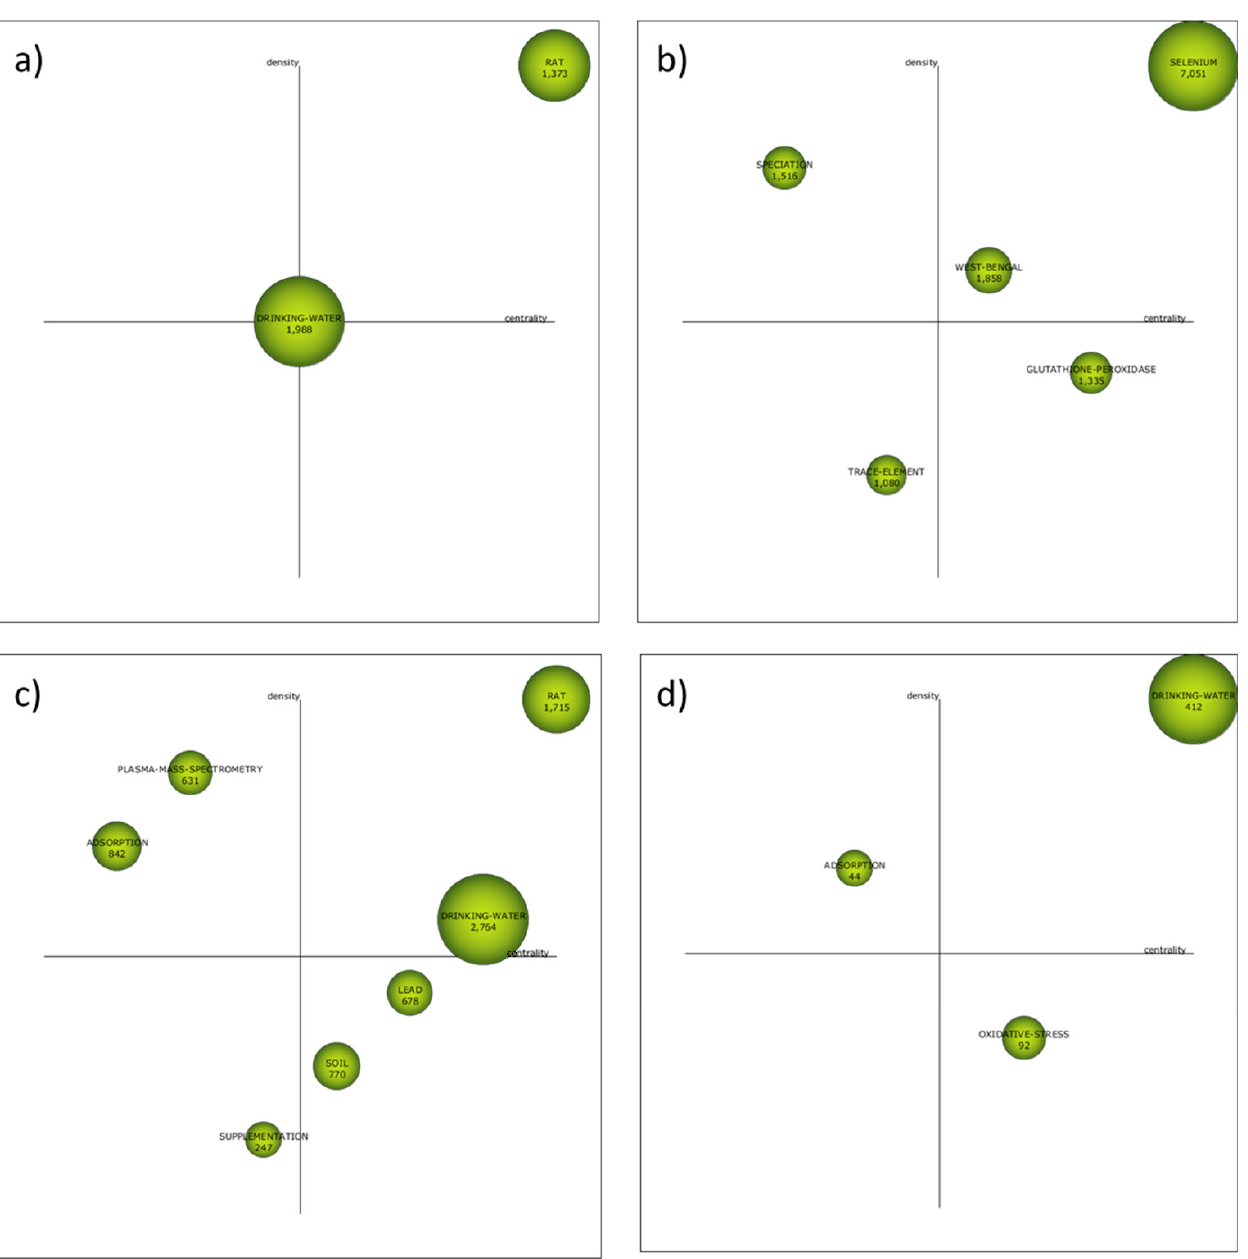
Figure 4. Strategic diagrams of the subperiods: 1990–2001 ( a ), 2002–2011 ( b ), 2012–2019 ( c ) and 2020–2021 ( d ).